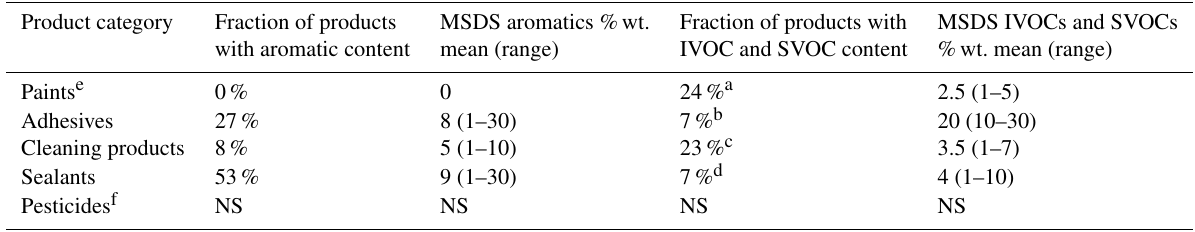
Table 2. Analysis of material safety datasheets commercially available with